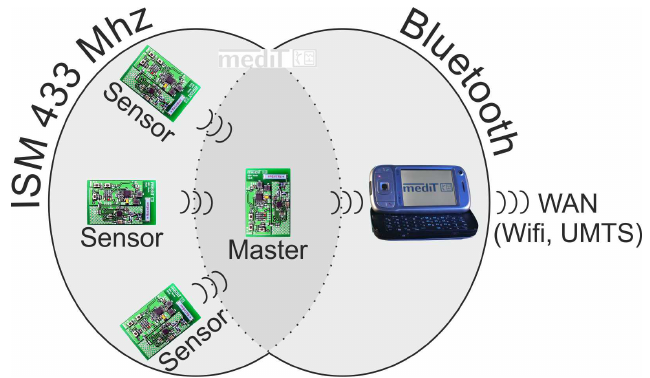
Figure 3. IPANEMA star-shaped network with three sensor slaves and one master module. Data are relayed to a PDA that can send the data over a WiFi or UMTS connection to a back-end